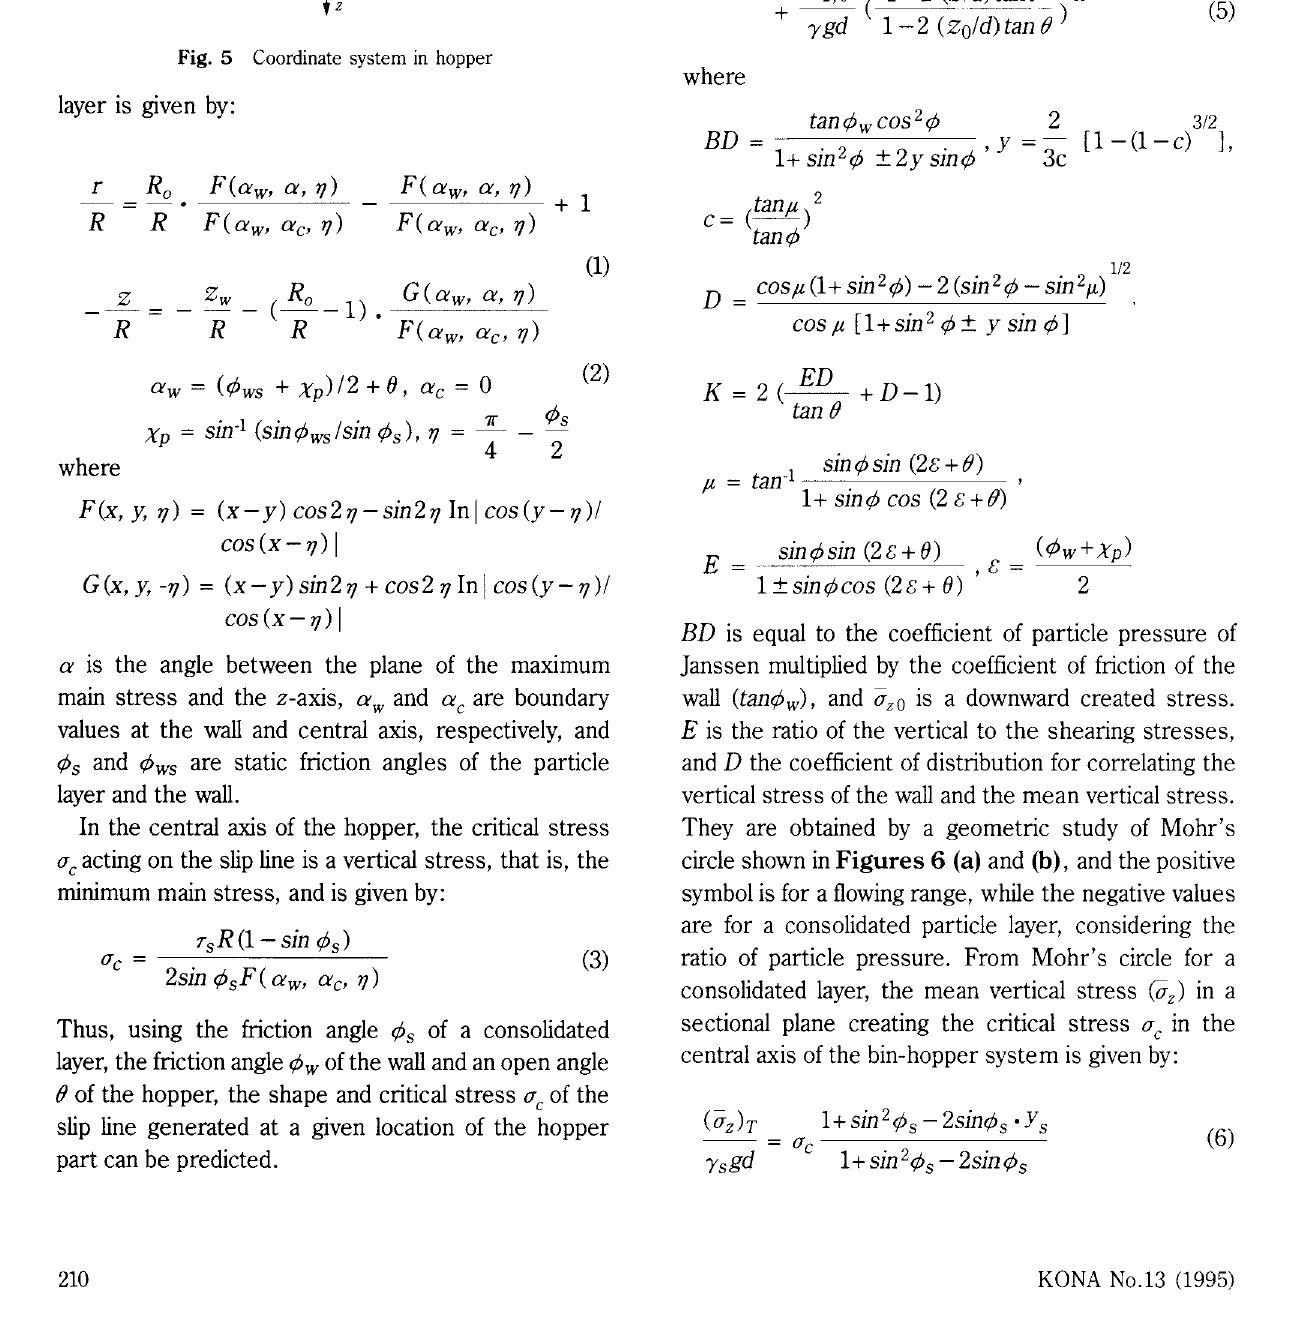
Fig. 5 Coordinate system in